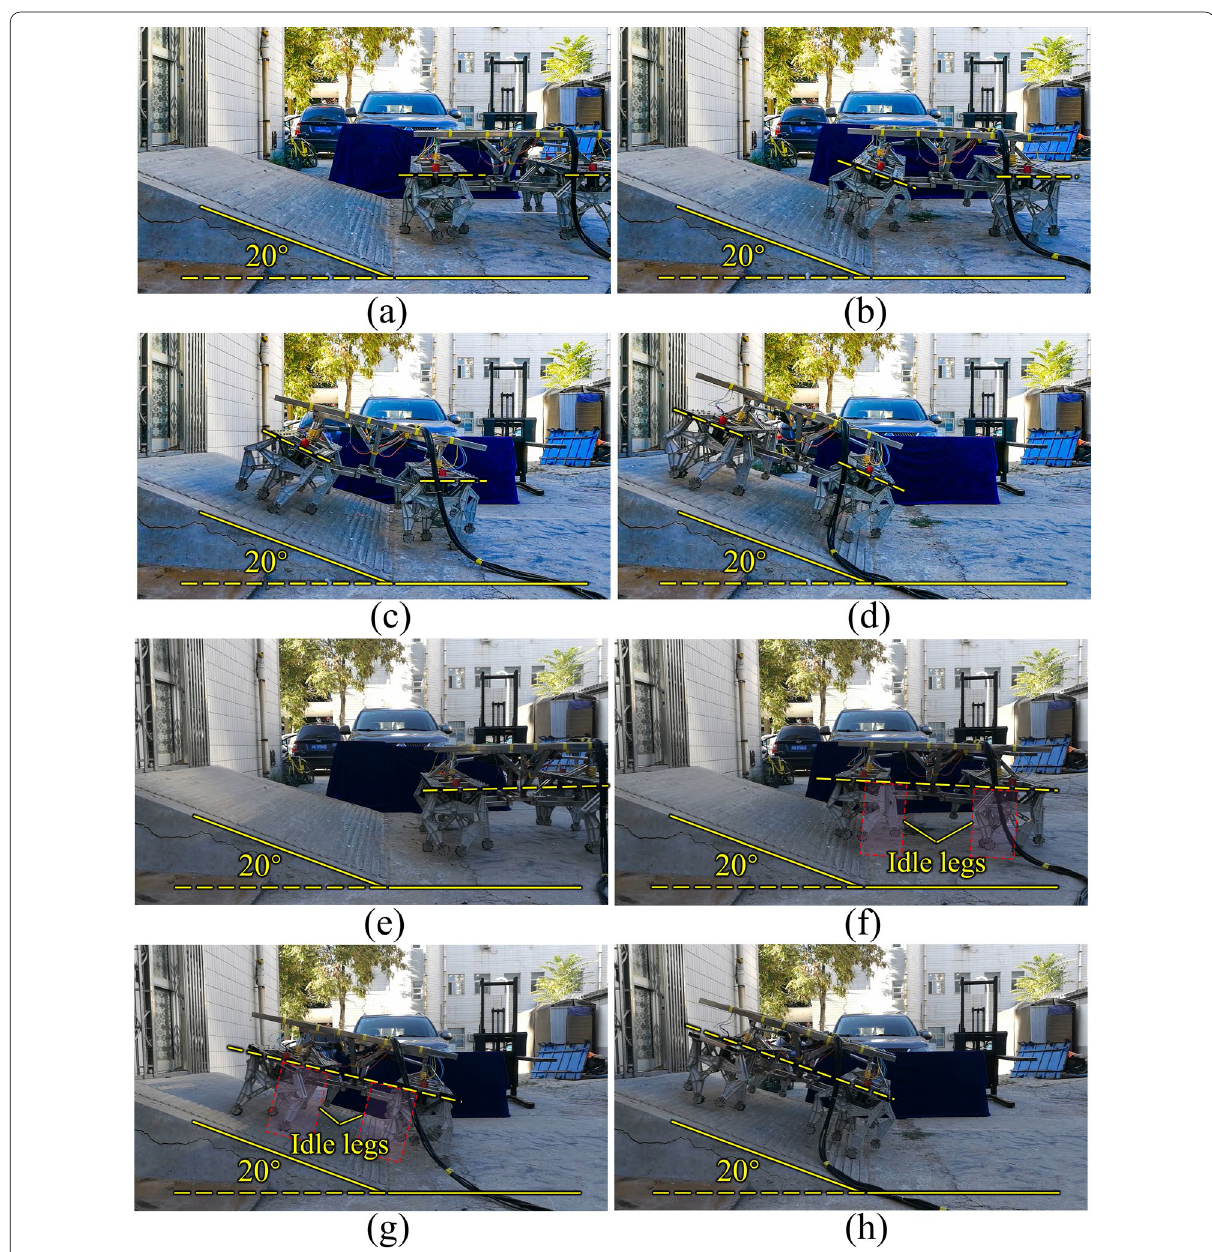
Figure 19 Experiments on 20°